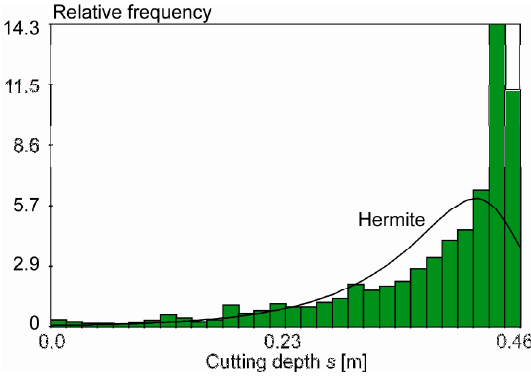
Fig. 12. Histogram of cutting depth